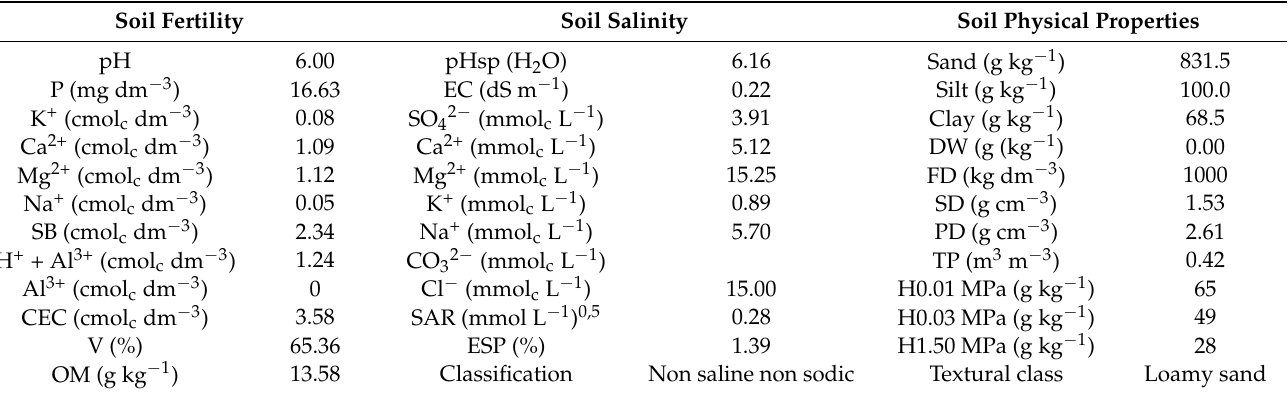
Table 3. Chemical (fertility and salinity) and physical properties of the soil (0–0.40 m depth) of the experimental area before the installation of experiment.